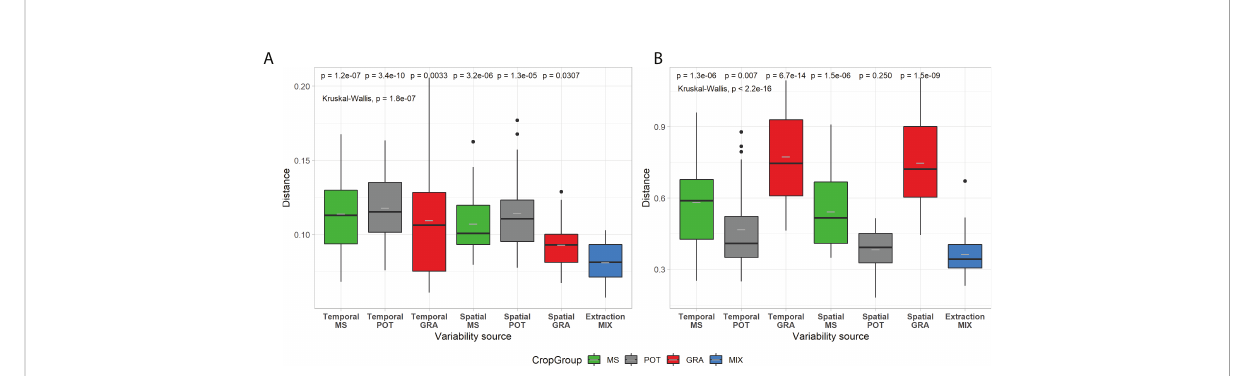
FIGURE 7 Box-and-whisker plots of weighted UniFrac distance for spatial, temporal and technical variability of prokaryotic (A) and fungal (B) communities. Boxplots are in the same format as those described in Figure 1. Kruskal-Wallis tests and post hoc pairwise Wilcoxon-test comparisons follow a similar format to Figure 1. Crop management codes and signi fi cance codes are the same as for Figure